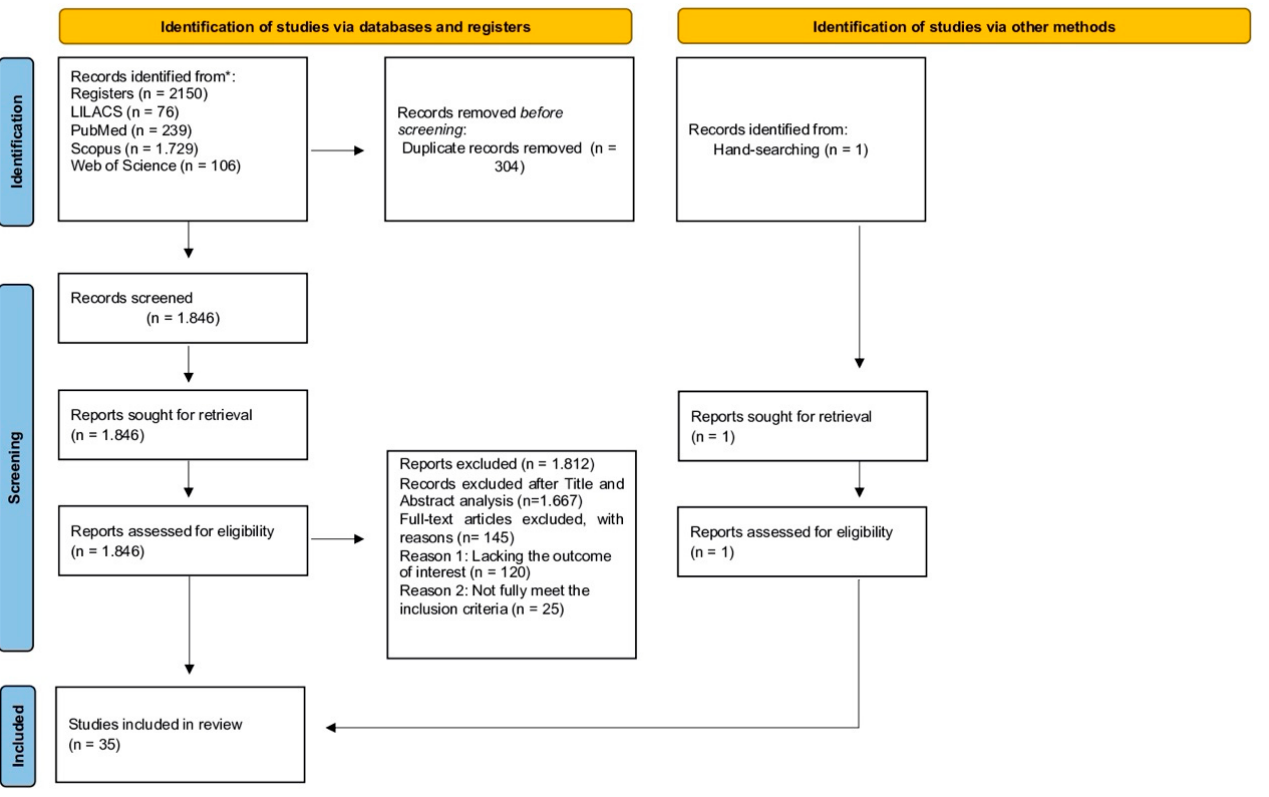
Figure 1. Flow diagram systematic search and review process.